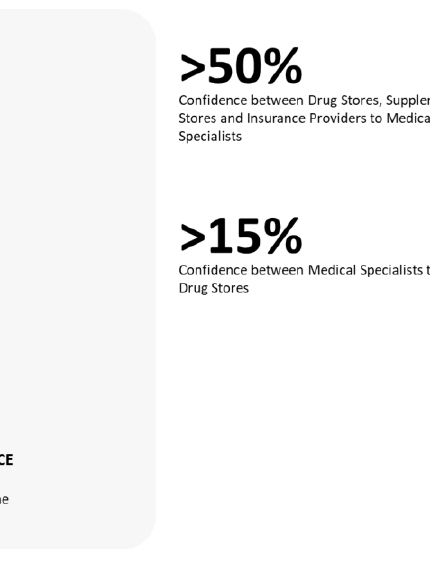
Figure 14. Merchant association rules for ‘ Chronically Ill ’ customers.